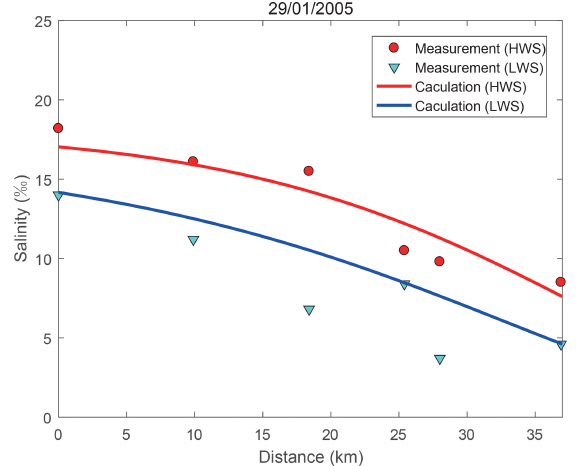
Figure 4. Comparison between calibration results and measured salinity concentration along the river on 29 January 2005, show- ing values of measured salinity at high water slack (circles) and low water slack (inverted triangles) and the calibrated salinity curves at high water slack (red curve) and low water slack (blue curve).